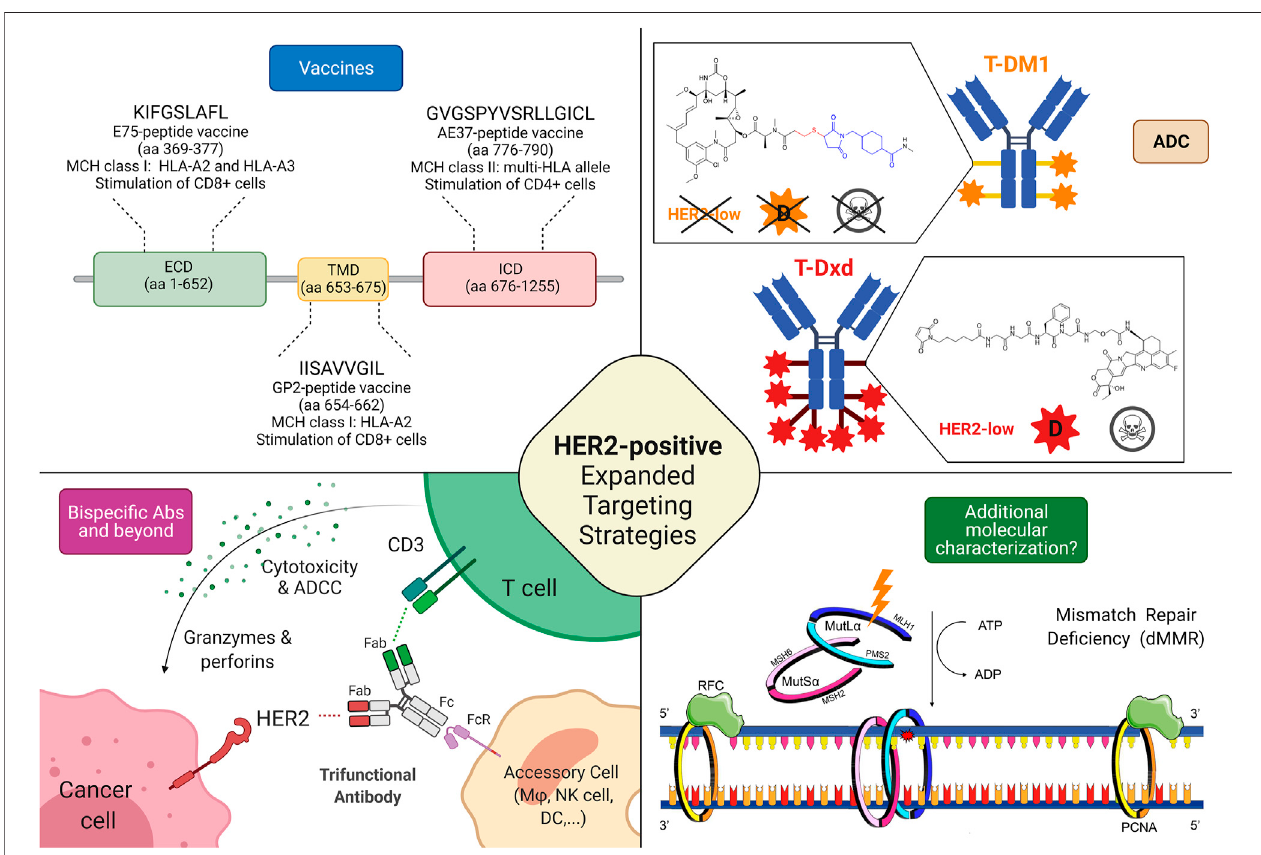
FIGURE 2 | Possible targeting strategies in HER2-low and HER2-negative breast cancers. 1) Cancer vaccines: most of the research efforts related to cancer vaccines against HER2 regard targeting HER2-related peptides, such as E75 (ECD), GP2 (TMD), and AE37 (ICD); Interestingly, while a phase II trial testing AE37-based vaccine in the advanced stage (in the study de fi ned as stage IIB or greater) did not demonstrate statistically signi fi cant survival bene fi t (5-years DFS) in the overall population, it showed a 5-years DFS of 83% in subjects with HER2-low disease, compared with 62.5% in the GM-CSF-only arm (HR, 0.375; CI: 0.142 – 0.988; p = 0.039). Similarly, in a subgroup with stage IIB or greater TNBC, a trend toward improved DFS with vaccination was found. The growing body of evidence coupled with subset analyses of this phase II trial led to another phase II clinical trial investigating AE37 in combination with pembrolizumab (NSABP FB-14) in TNBC patients with metastatic disease (NCT04024800). 2) Antibody-drug conjugates: several trials are currently testing ADC in HER2-low disease, with interesting results, particularly regarding those equipped with diffusable cytotoxic moiety as well as cleavable linkers, possibly accounting for bystander killing effect (skull symbol); 3) Bispeci fi c antibodies (bsAbs) and trifunctional antibodies are characterized by the ability to target (at least) two different epitopes, enabling either inhibition of multiple oncogenic pathways or the forced connection between immune cells and cancer tissue. Several anti-HER2 bsAbs are under development, although only a minority is speci fi cally investigated in HER2-low disease; 4) Additional molecular characterization is a possible new prospective, in the light of recent fi ndings describing the predictive value of mismatch repair de fi ciency related to response to HER2 blockade in HER2-negative breast cancer. Abbreviations: T-DM1, trastuzumab emtansine; T-DXd, trastuzumab deruxtecan; HER2, human epidermal growth factor receptor 2; ECD, extracellular domain; TMD, transmembrane domain; ICD, intracellular domain; aa, amino acid; MHC, major histocompatibility complex; HLA, human leukocyte antigen; ADC, antibody-drug conjugate; D, diffusible cytotoxic moiety; MSH6, MutS Homolog 6; PMS2, PMS1 Homolog 2; MSH2, MutS Homolog 2; MLH1, MutL homolog 1; DFS, disease-free survival; bsAbs, bispeci fi c antibody; CD, cluster of differentiation; ATP, Adenosine triphosphate; ADP, adenosine diphosphate; Fab, antigen-binding fragment; Fc, fragment crystallizable; FcR, Fc receptor;